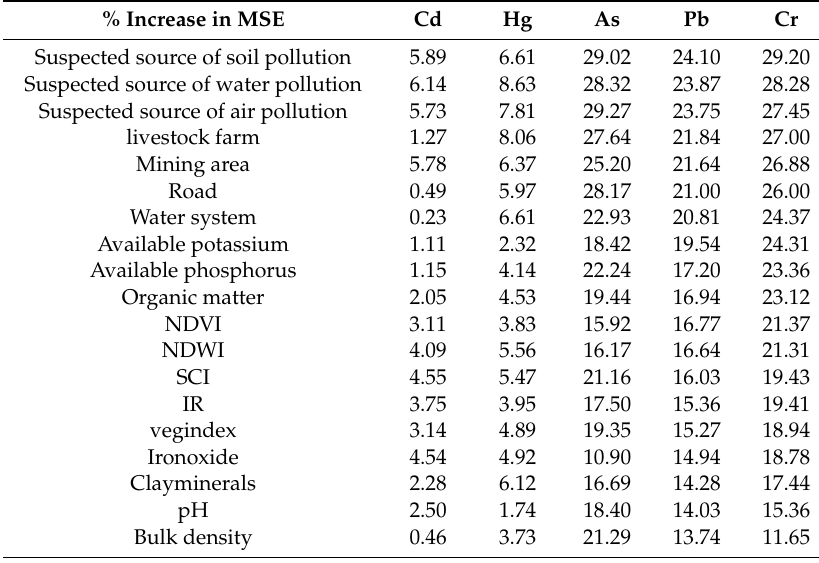
Table 6. Results of the variable importance measures (% increase in mean squared error (MSE)) in